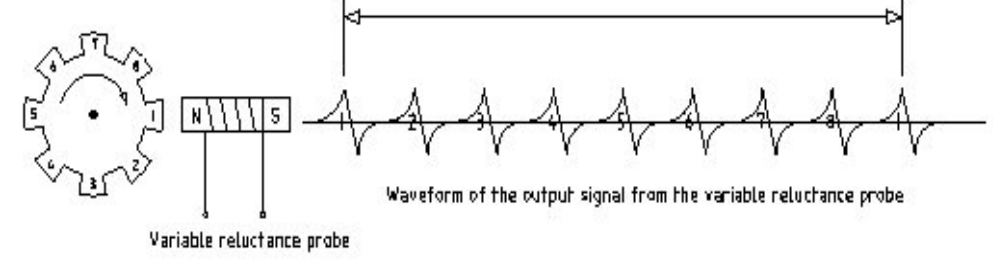
Figure 1. The sensor.